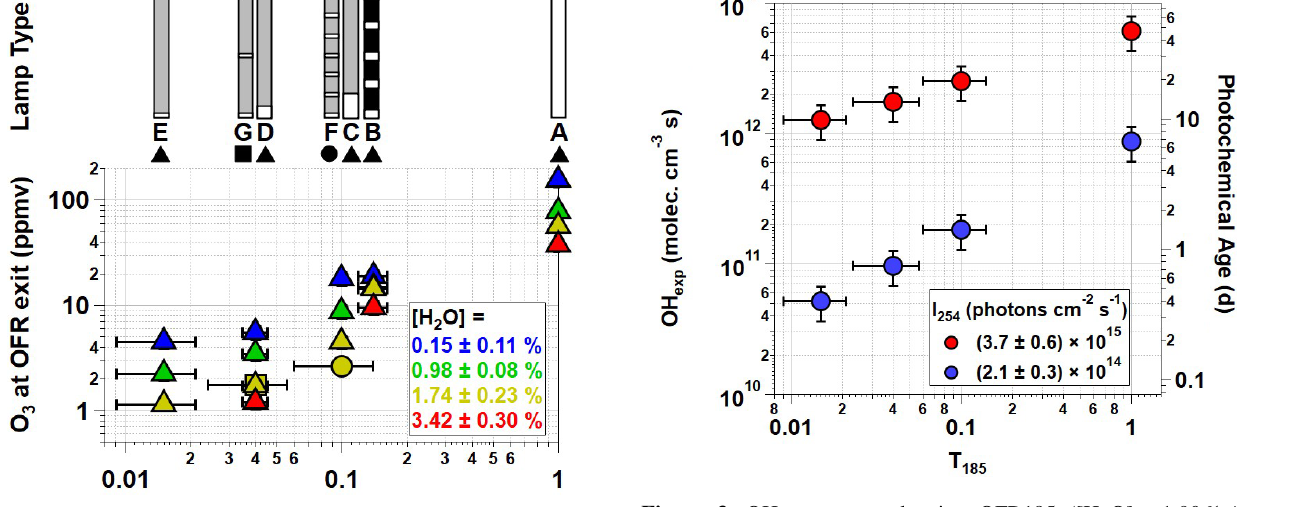
Figure 3. OH exp generated using OFR185 ( [ H 2 O ] = 1 . 90% ± 0 . 26%) at minimum and maximum I 254 for each T 185 value. Cor- responding photochemical age is shown on the right y axis assum- ing mean [ OH ] = 1 . 5 × 10 6 moleccm − 3 (Mao et al., 2009). Error bars assume ± 30% uncertainty in OH exp and ± 2mm uncertainty in lengths of individual T 185 = 0 and 1